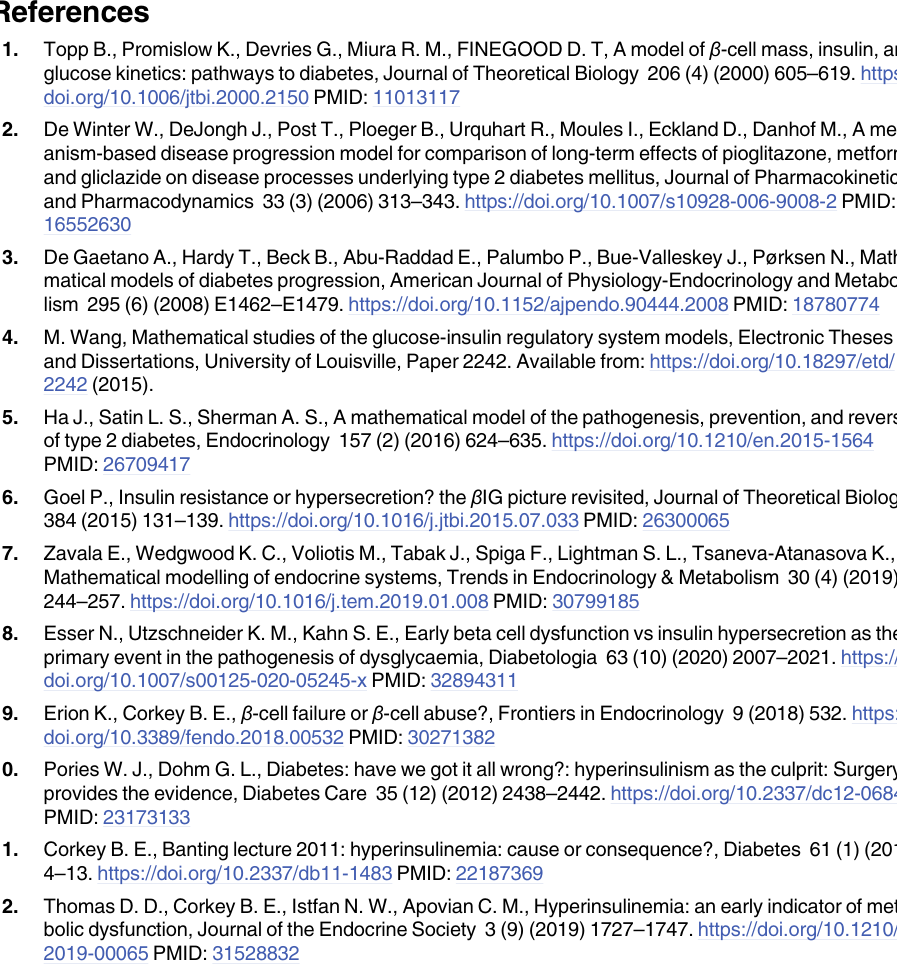
S4 Fig. The influence of parameter n